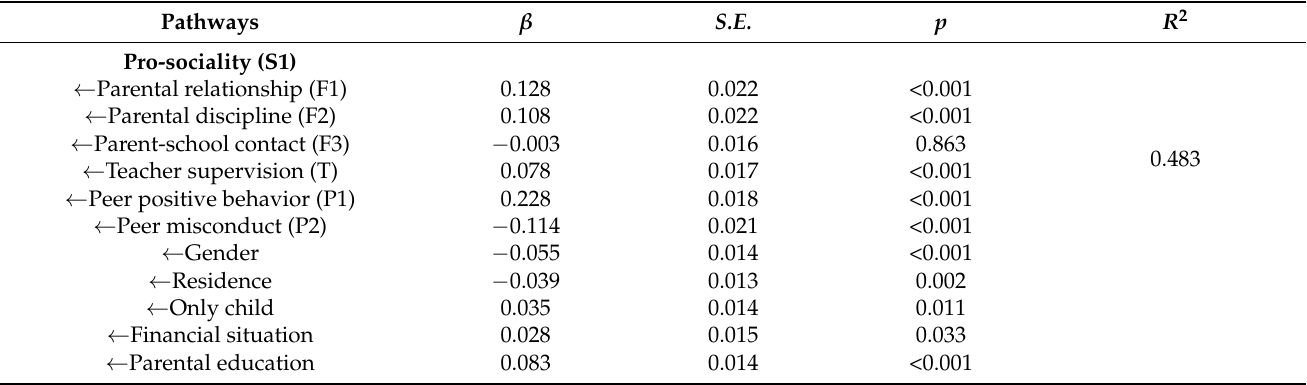
Figure 1. Structural equation model path diagram. Table 3. Structural model path coefficients n = 7835.